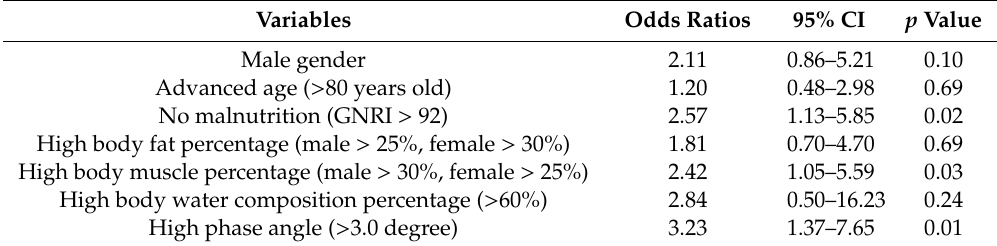
Table 3. Associations between functional recovery and clinical